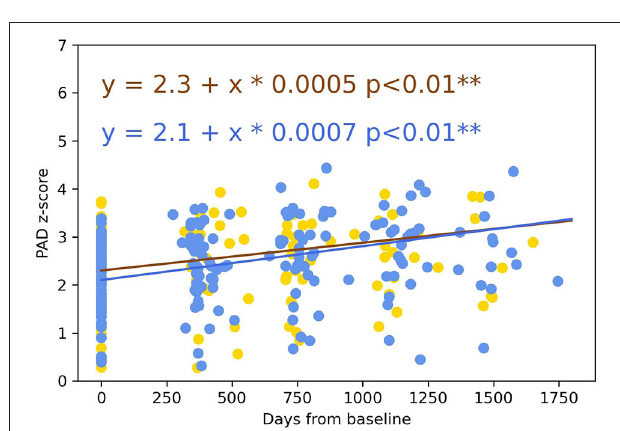
FIGURE 10 | Longitudinal evolution of the PAD over 4 years between amnestic and non-amnestic patients. Lines represented trajectories using linear-mixed-effects models (yellow line: non-amnestic EOAD and blue line: amnestic EOAD). The two coefficients of the regression were not statistically different (Chow test, p = 0.096). PAD, predicted age difference; EOAD, early-onset Alzheimer’s disease. ** p < 0.05.